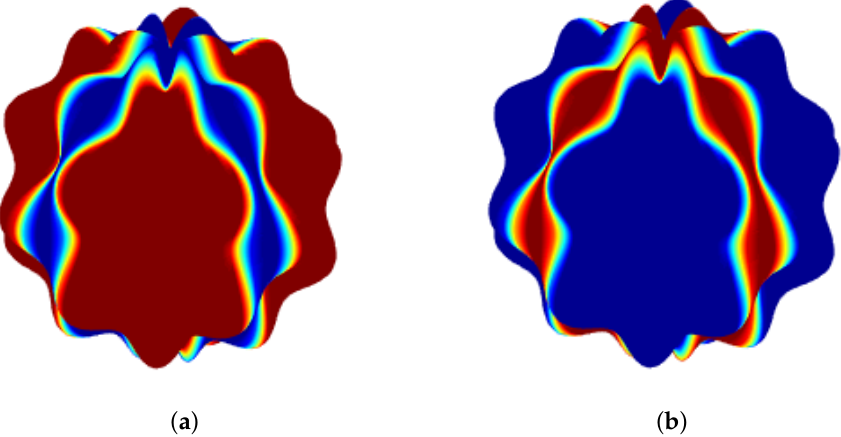
Figure 9. The plot of approximate solution of u ( a ) and the plot of approximate solution of v ( b ) with TPS for Example 4 by taking dx = 1 , and τ = 0.5 dx 2 8